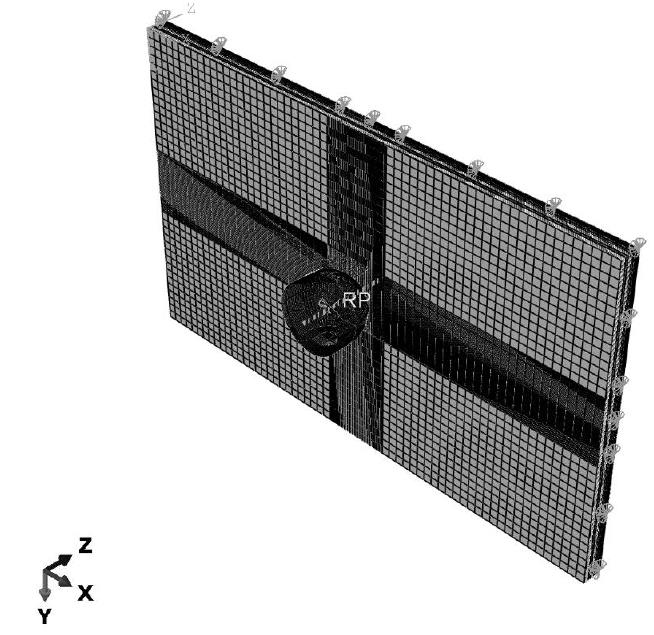
Figure 11. Finite element model.